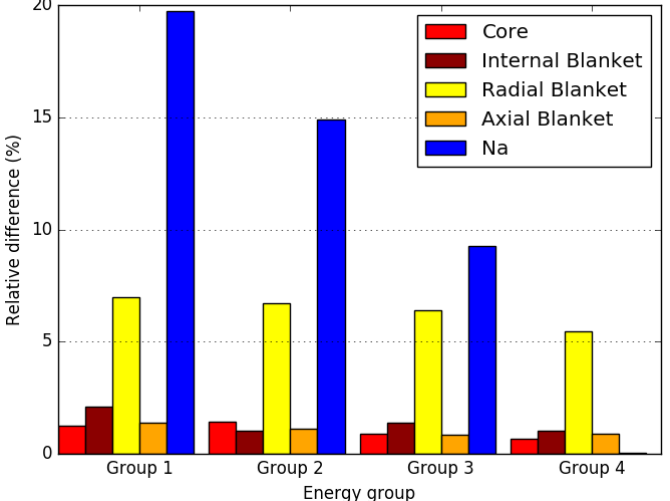
Figure 16. Comparison of region-averaged flux from reference and Parafish Model 3 Case 2.